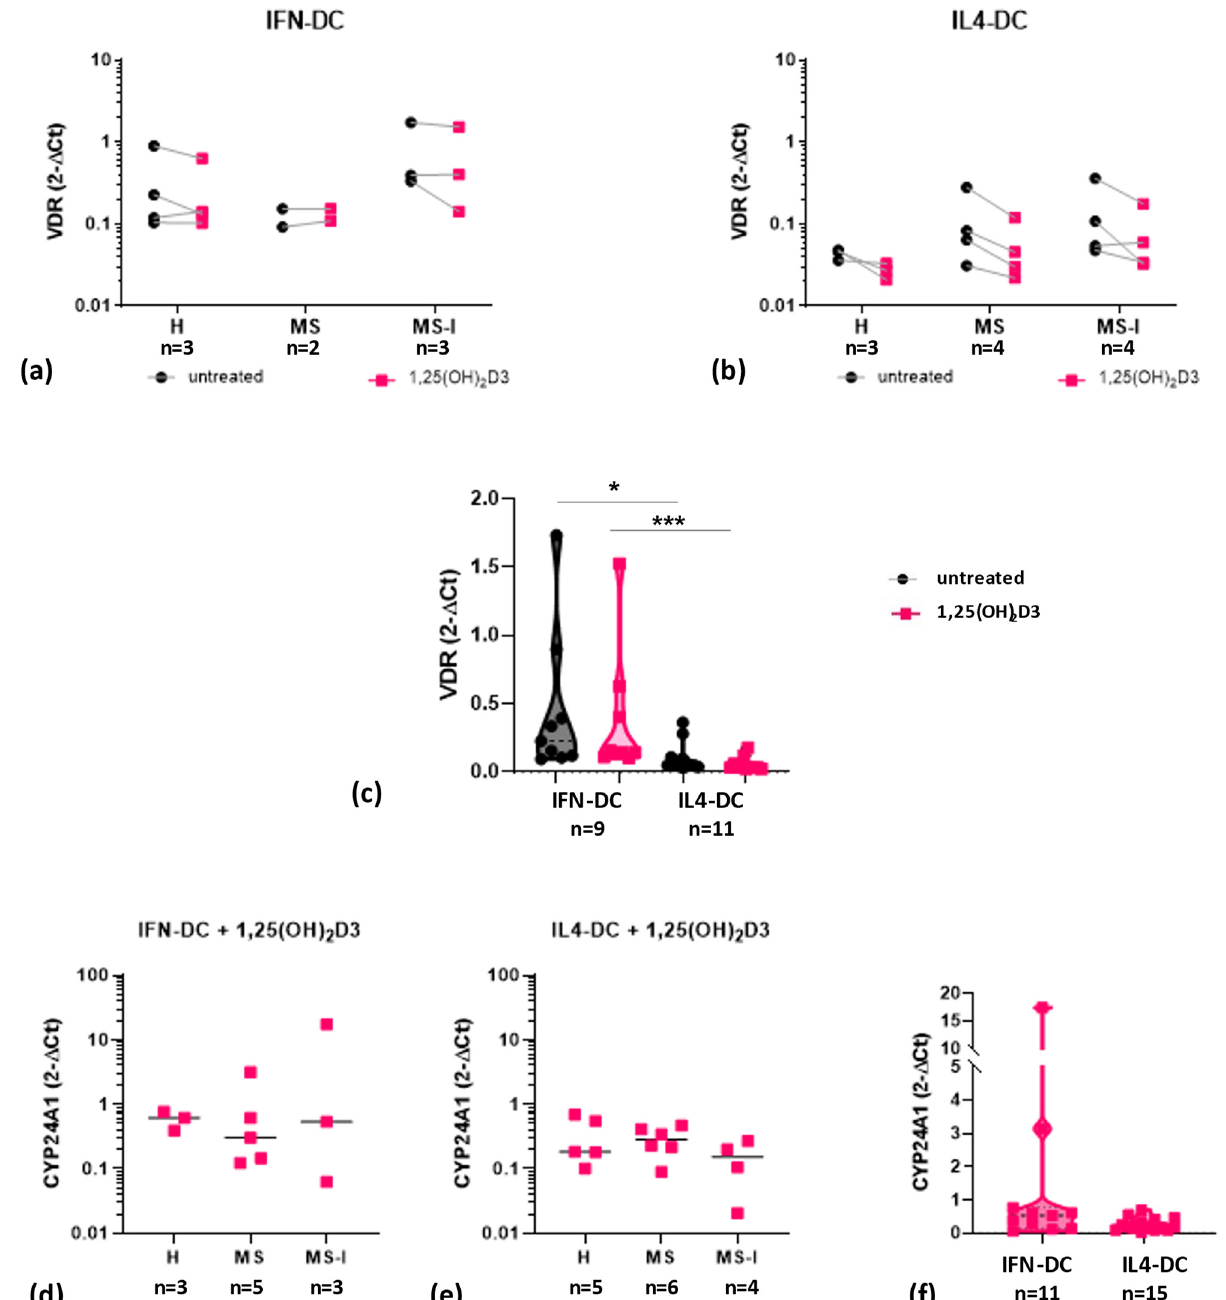
Figure 2. Expression and modulation by 1,25(OH) 2 D3 of vitamin D receptor ( VDR ) and CYP24A1 mRNA. VDR ( a – c ) and CYP24A1 ( d – f ) mRNA expression in IFN-DC ( a , d ) and IL4-DC ( b , e ) were analyzed by quantitative RT-PCR and expressed as 2 − ∆ CT values. GAPDH was used as reference gene. Violin plot of VDR ( c ) and CYP24A1 ( f ) mRNA data after pooling data obtained from the three donor groups. Cell type effects (e.g., quantitative differences between IFN-DC and IL4-DC) were tested by Kruskal–Wallis test with Dunn’s post-test for multiple comparisons for VDR and Mann–Whitney test for CYP24A1 . Number of subjects (n) analyzed are indicated under each panel. Black dots indicate untreated cells, pink squares indicate 1,25(OH) 2 D3 treated cells; * p ≤ 0.05, *** p ≤ 0.001.